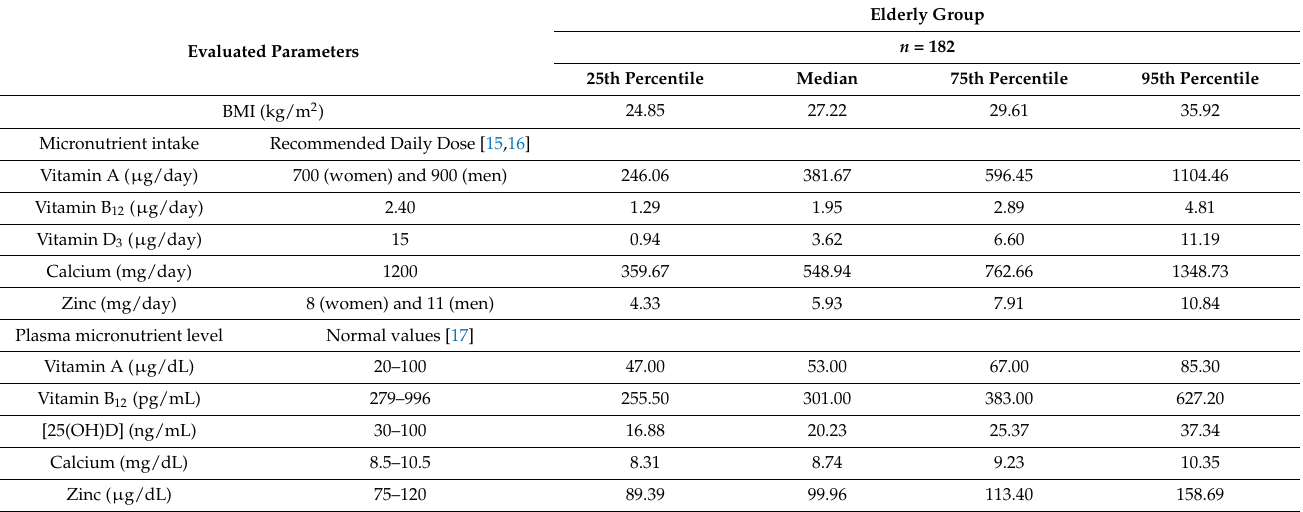
Table 1. BMI, micronutrient intake and serum micronutrient levels of an elderly group from Metropoli- tan Region, Santiago, Chile.